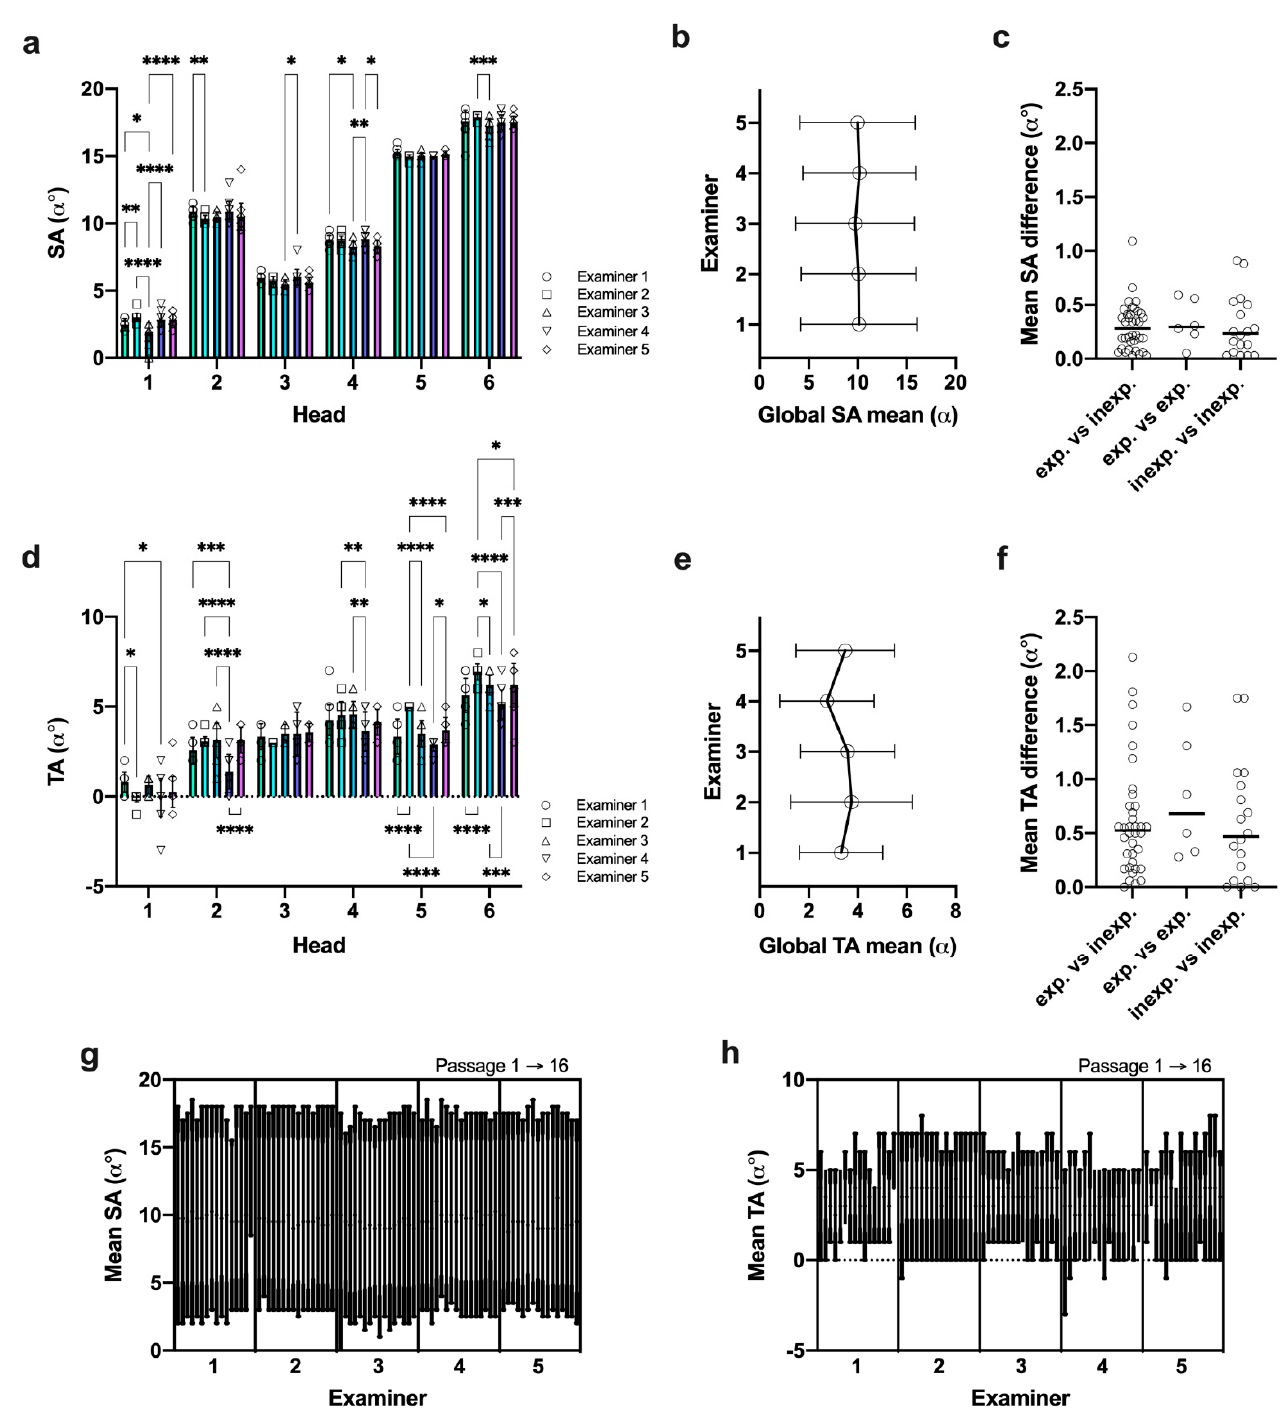
Figure 7. Analysis of SA and TA measurement reproducibility. ( a , d ) SA and TA measures per examiner*head (symbols = individual examiner measures); SA: n = 16(15), TA: n = 16(13, head 1) measures per head; two-way ANOVA, p < 0.0001; Tukey’s multiple comparisons, * p < 0.05, ** p < 0.01, *** p < 0.001, **** p < 0.0001. ( b , e ) Global SA and TA mean ± 95% confidence intervals. ( c , f ) Examiner dependency analysis for mean angle differences; exp. vs. inexp.: n = 36, exp. vs. exp.: n = 6, inexp. vs. inexp.: n = 18; Kruskal–Wallis test, p = 0.692 (SA), p = 0.630 (TA). ( g , h ) Nested angle values in passage chronology; SA: n = 16(15), TA: n = 16(13) measures per head.